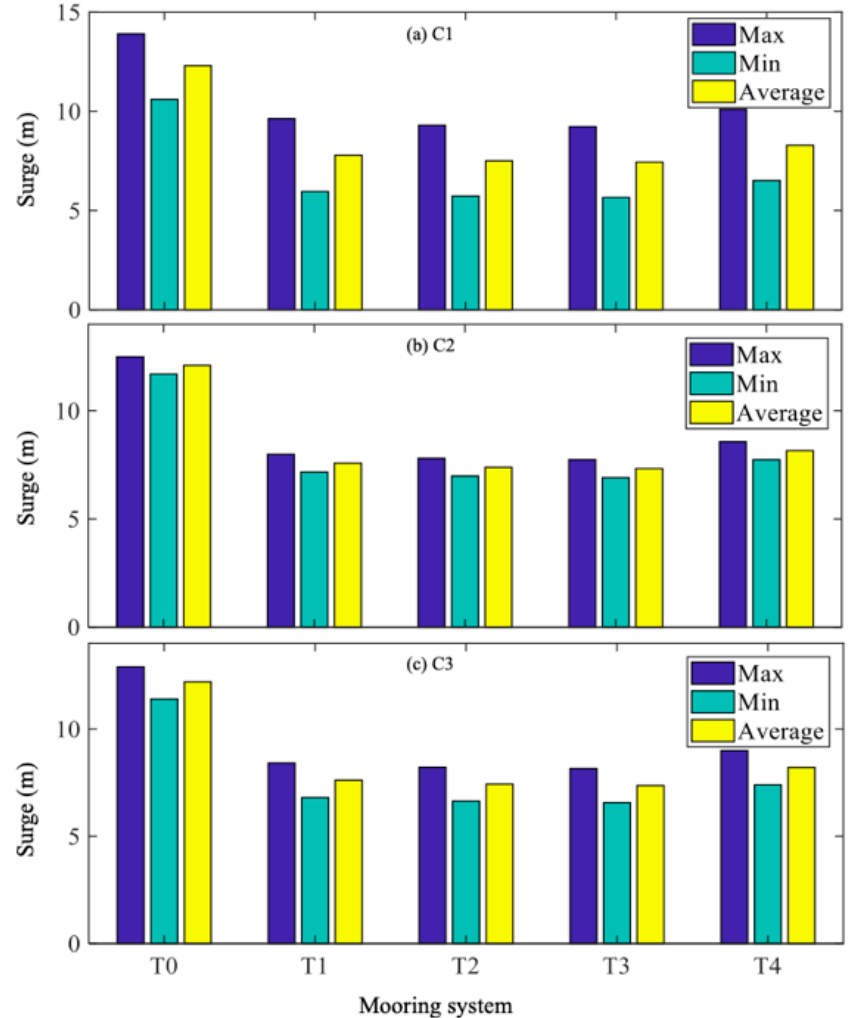
Figure 10. Surge movement maximum, minimum, and average values in ( a ) C1, ( b ) C2, and ( c ) C3. Figure 12 presents wind turbine yaw movement maximum, minimum, and average values for T0–4 under C1–3. The yaw movement maximum value of T0 was slightly larger than those of T1–4, while the yaw movement maximum values of T1–4 were almost the same. In C1, the yaw movement maximum value of T0 was 0.308 ◦ , and it was 0.27 ◦ for T3. This indicates that the optimal configuration for the developed mooring system (T3) could reduce wind turbine yaw movement by approximately 12.34%. Generally, the developed mooring system with three fairleads and 40 ◦ included angle performed better than that with six